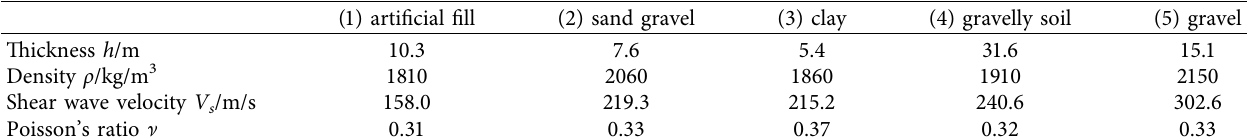
Table 2: Properties of the ground layers.